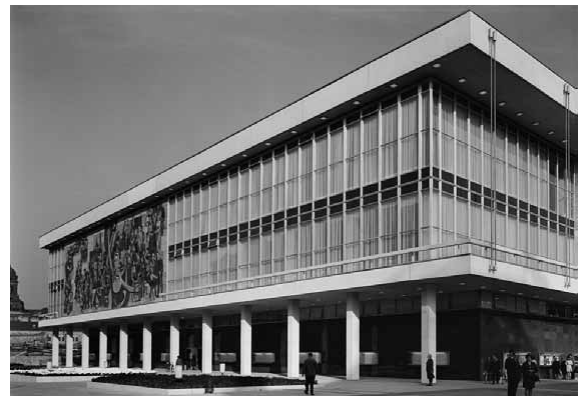
fig. 1. Kulturpalast Dresden with the mural Der Weg der Roten Fahne , Schlossstraße, 1969. SluB Dresden / Deutsche fotothek / Manfred Thonig